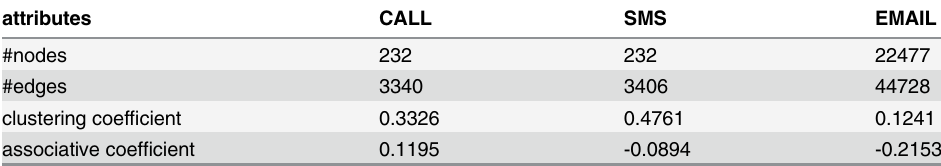
Table 5. Network topology characteristics. M: Managers; S: